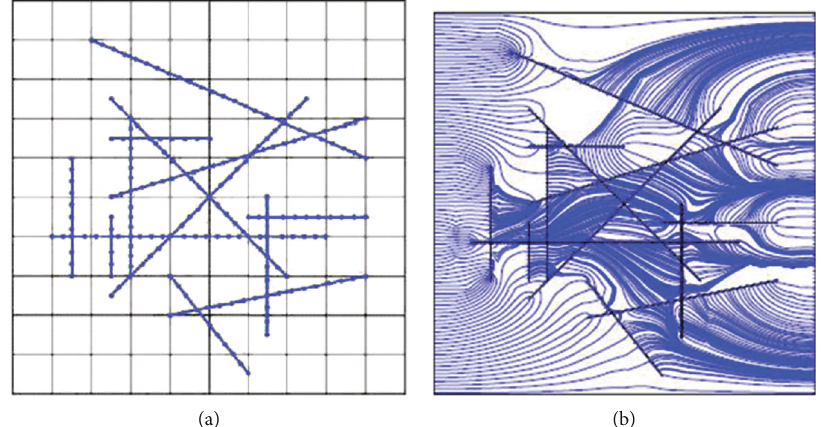
Figure 12: Benchmark model, with (a) fracture geometry. Permeability ratios are R k = 10 4 . (b) Flow paths generated with EDFM and uniform pressure at the left-hand boundary is normalized with the right-hand boundary held at zero pressure. After [56].